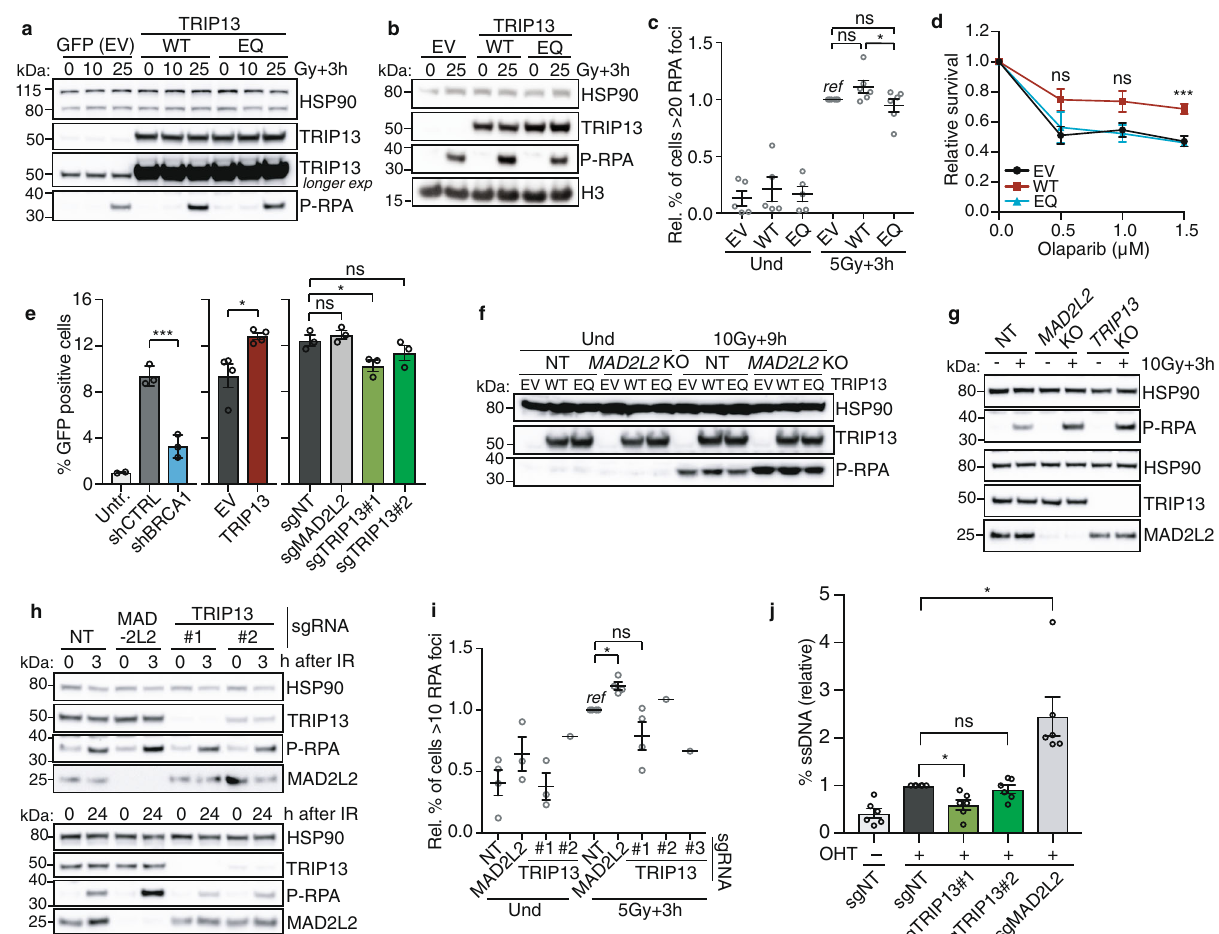
Fig. 4 TRIP13 affects DNA repair. a Immunoblot of HeLa cells transduced with wild-type TRIP13 (WT), ATPase-dead TRIP13 (EQ) or GFP-control vector (EV), 3 h post IR (10/25Gy). HSP90 as loading control. Representative of n = 3. b Immunoblot of U2OS cells transduced as in a (25 Gy + 3 h), representative of n = 4. c RPA-foci in U2OS transduced as indicated, untreated (Und) or 3 h post IR (5 Gy), normalized to control (EV). Dots represent n = 6 biological replicates, except “ Und ” ( n = 5), 115 – 600 cells analyzed/condition/replicate, mean ± s.e.m., one-way ANOVA, Tukey ’ s multiple comparisons test on IR-treated samples (ns p = 0.2109 (EV vs. WT) and p = 0.6638 (EV vs. EQ); * p = 0.0385). d Survival of U2OS transduced as b , c , treated with olaparib for 19 days ( n = 4 biological replicates, showing mean ± s.e.m., one-way ANOVA, Dunnett ’ s multiple comparisons test for each concentration, signi fi cance shown for EV vs. WT, ns p = 0.1166 (0.5 μ M) and p = 0.0846 (1.0 μ M); *** p = 0.0007 (1.5 μ M)). e DR-GFP (HR) assay in U2OS, shRNAs/sgRNA infected or transfected with untagged-TRIP13 (EV, empty vector control). DSBs were induced with I-SceI, except for “ Untr ” . Dots show independent replicates, mean ± s.e.m., one-way ANOVA (Dunnett ’ s) (shRNA/sgRNA-treated cells, n = 3 except “ Untr ” ( n = 2), *** p = 0.0006; ns p = 0.0720 (sgNT vs. sgMAD2L2) and p = 0.7091 (sgNT vs. sgTRIP13#2); * p = 0.0332) or unpaired two-tailed t -test (TRIP13 overexpression set, n = 4, * p = 0.0173). f Immunoblot of transduced control (NT, non-target) or MAD2L2 KO U2OS cells, untreated (Und) or 9 h post 10 Gy. g Immunoblot of long- term polyclonal TRIP13 KO U2OS cells, a MAD2L2 KO U2OS clone and NT control cells, harvested 3 h post IR. Representative of n = 5. h Immunoblot of transduced U2OS cells, untreated (0 h) or 3 h and 24 h post IR (10 Gy). Representative of n = 3. i RPA-foci in U2OS transduced as in h , untreated (Und) or 3 h + 5 Gy, normalized to sgNT. Dots represent n = 4 individual experiments, except sgTRIP13#2/3 ( n = 1), 100 – 600 cells/condition/replicate, mean ± s.e.m., one-way ANOVA (Dunnett ’ s) for sgNT, sgMAD2L2, sgTRIP13#1 (ns p = 0.2516; * p = 0.0140). j Quanti fi cation of single-stranded DNA in RT – PCR-based end-resection assays in sgRNA-transduced U2OS-DIvA cells after DSB induction with 4-hydroxytamoxifen (OHT) or untreated (-). Mean± s.e.m., n = 6, one-way ANOVA (Dunnett ’ s) (ns p = 0.7939; * p = 0.0332 (sgNT vs. sgTRIP13#1) and p = 0.0445 (sgNT vs. sgMAD2L2). Signi fi cance; ns, not signi fi cant ( p ≥ 0.05), *p < 0.05, ** *p < 0.001. Source data are provided as a Source Data fi